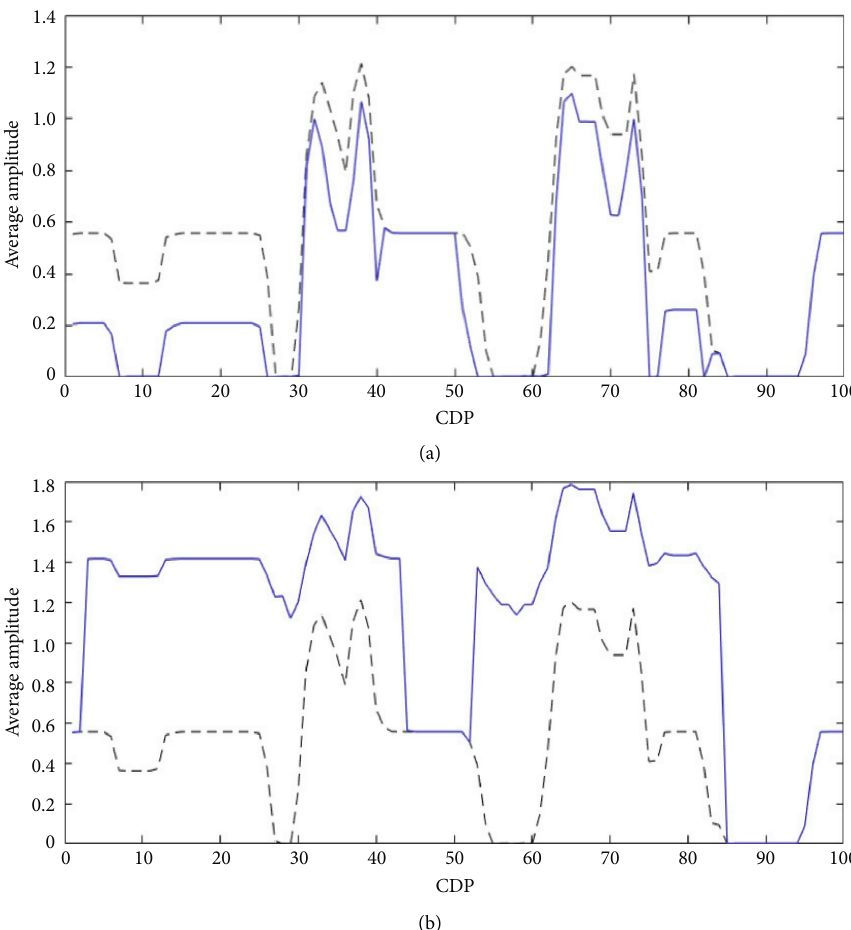
Figure 12: Contrast diagram of the average amplitude extracted from the synthetic seismic records of channel reservoir with and without interference at 30Hz. (a) Noninterference and upper interference. (b) Noninterference and lower